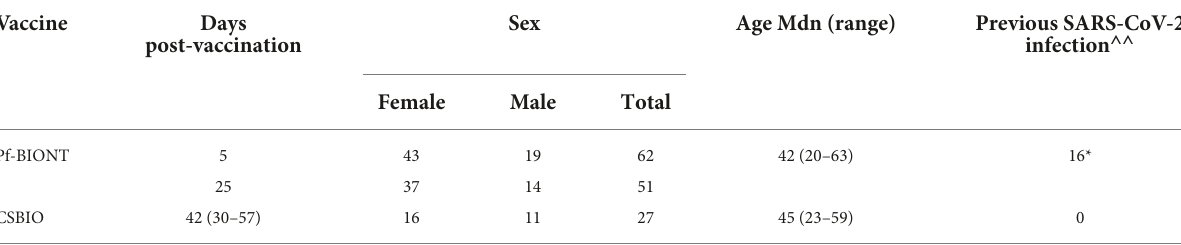
TABLE 1 Demographics features of enrolled participants vaccinated against COVID-19 including type of vaccine, days post-vaccination, sex, age, and previous reports of confirmed symptomatic COVID-19.